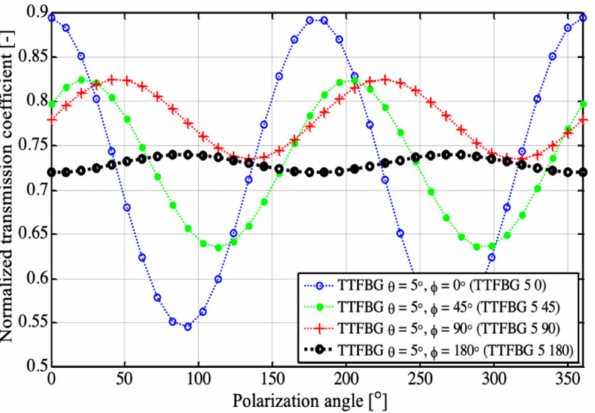
Figure 12. Measurement results of the transmission coefficient variation of the TTFBG structure for different twist angles φ